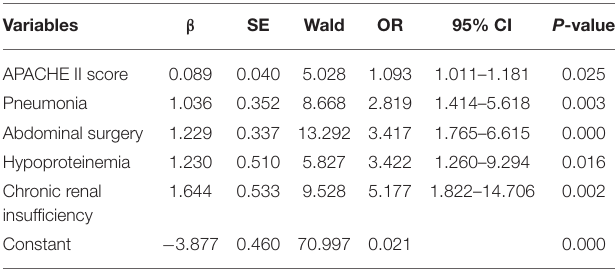
TABLE 2 | First step of logistic regression analysis of significant variables related to in-hospital death in patients with intra-abdominal infection.